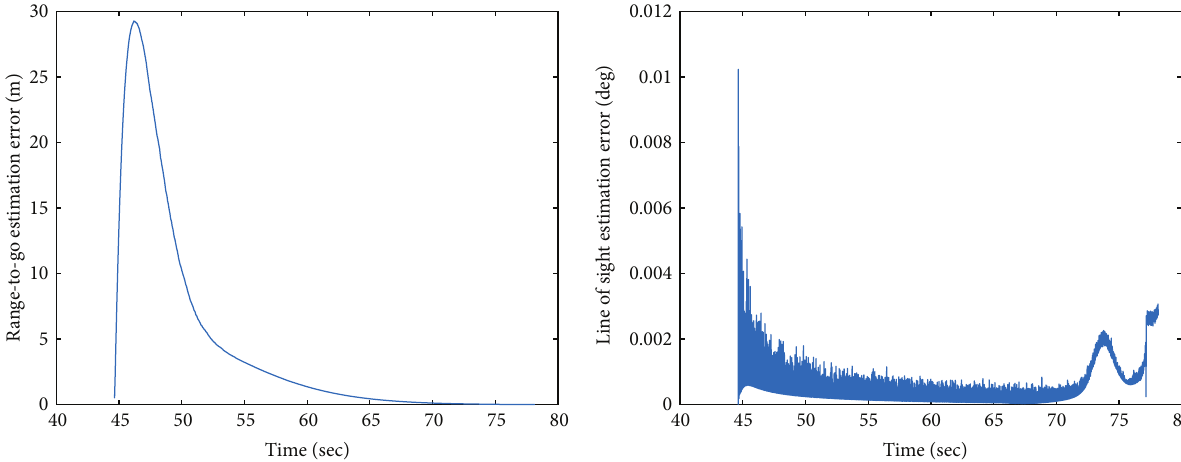
(b) Norm of the line of sight estimation error versus time in terminal phase